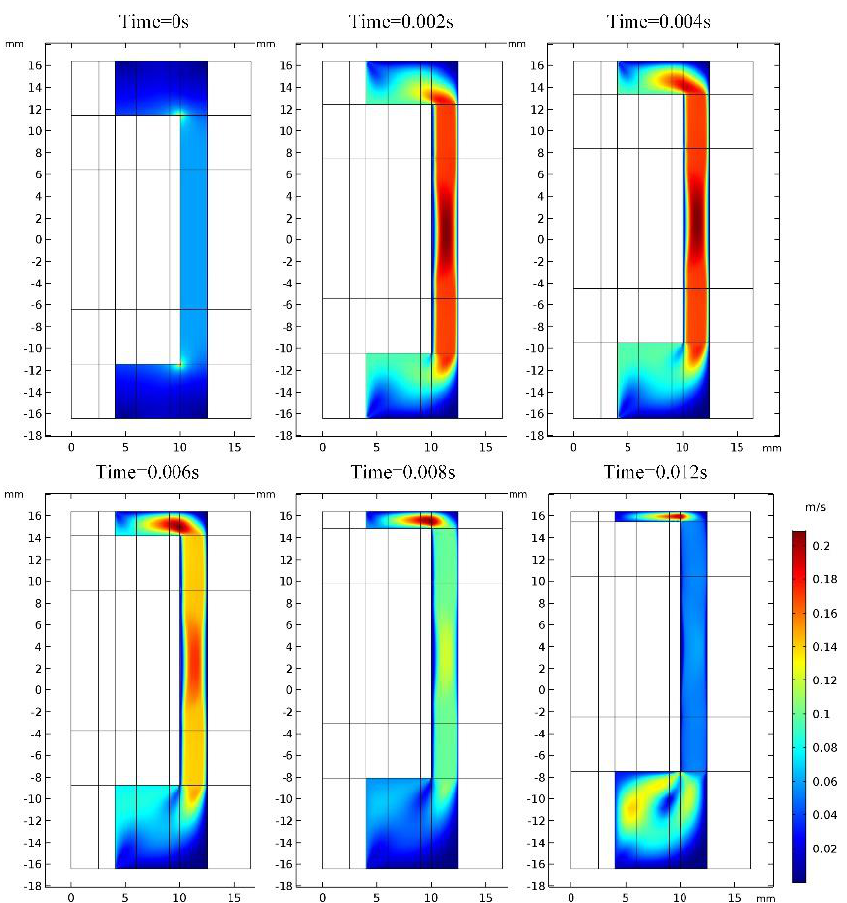
Figure 11. Velocity distribution map of the MR fluid when the current is 2.5 A.